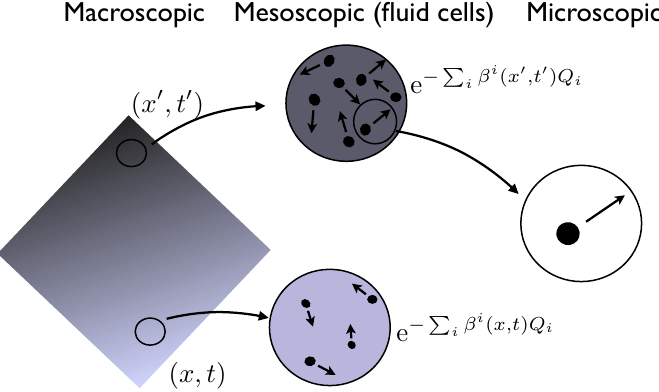
Figure 3: The separation of scales at the basis of the hydrodynamic approximation. and the second term is a consequence of Galilean